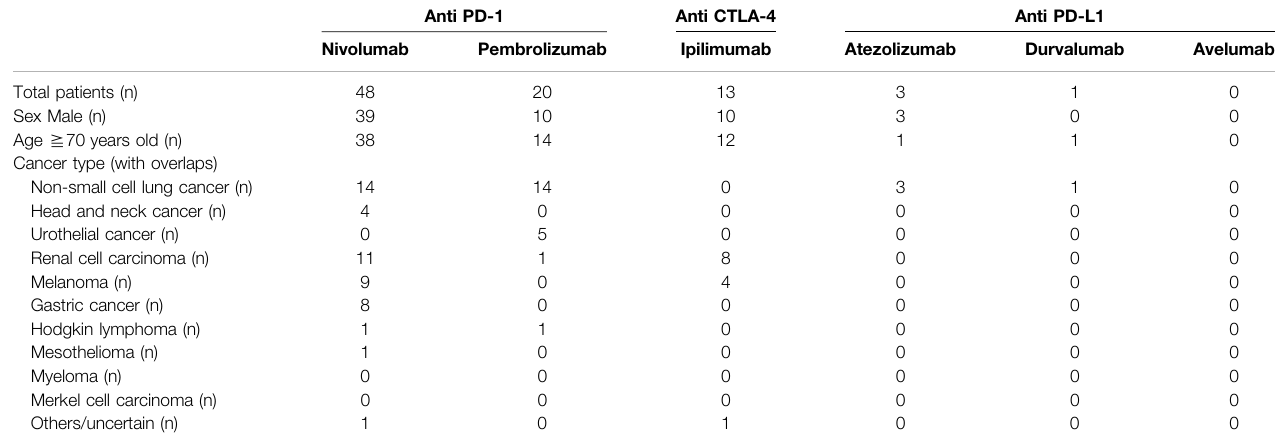
TABLE 3 | Characteristics of patient with vasculitides.